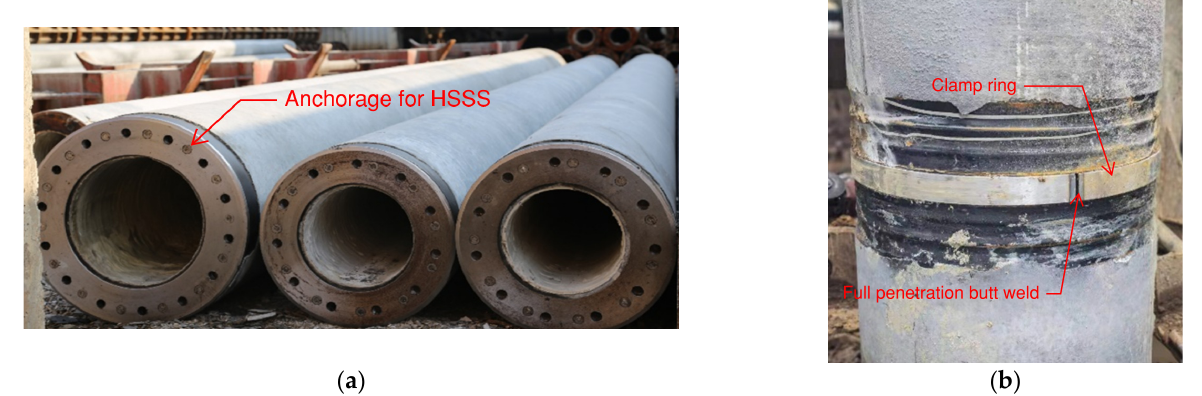
Figure 1. Schematic graph of Combination Splice: ( a ) Splice plates; ( b ) Clamp ring.